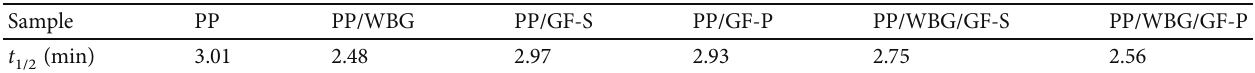
) values as a function of crystallization time ( t ) for samples at a cooling rate t Table 3: t of 2/1